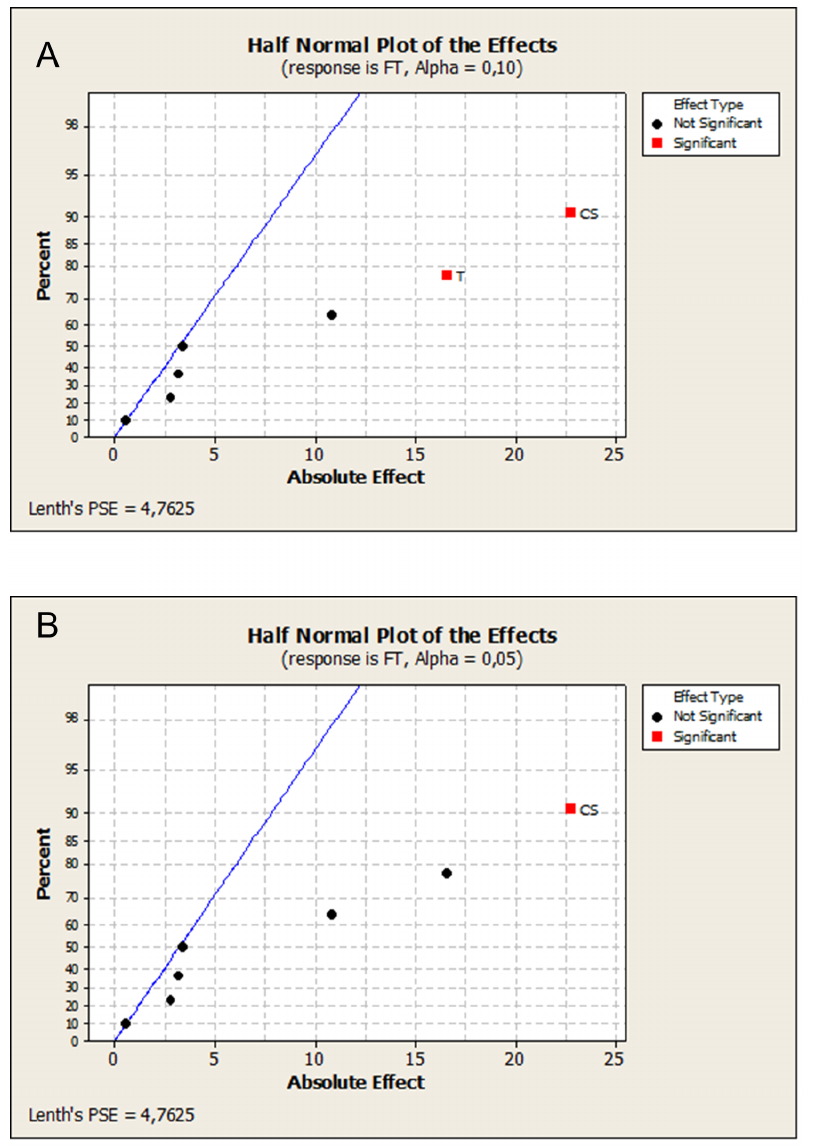
Figure 5. Half-normal plot (MINITAB 16.0) of the effects for the screening of filtration time for significance levels, a =0.1 (A) and a =0.05 (B).